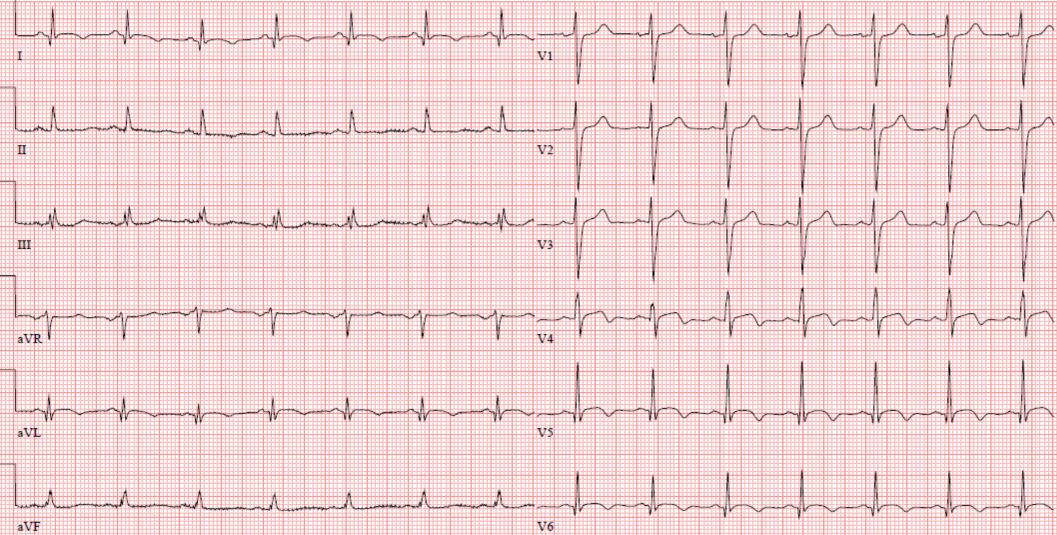
Figure 1. Initial electrocardiogram on admission to the hospital: sinus rhythm, ST-T abnormalities in V4–V6, I and aVL, left axis deviation, QTc 446 milliseconds. Transthoracic echocardiography revealed normal ventricular dimensions, no regional wall motion abnormalities, and a mildly reduced LV global systolic function, which nor- malized in the following weeks.